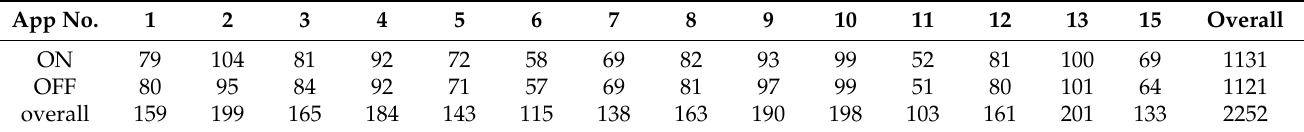
Table 4. Number of events related to the switch off or on events for selected